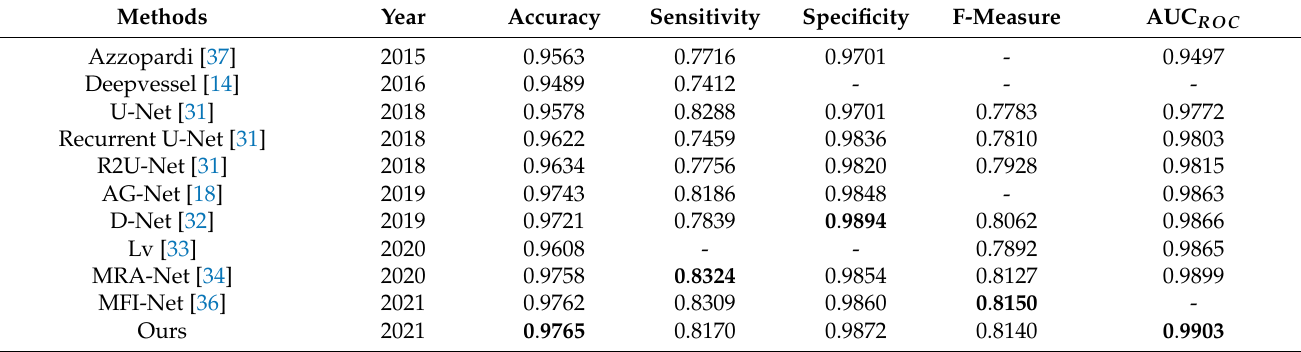
Table 4. Comparison of proposed methods with other methods on the CHASE